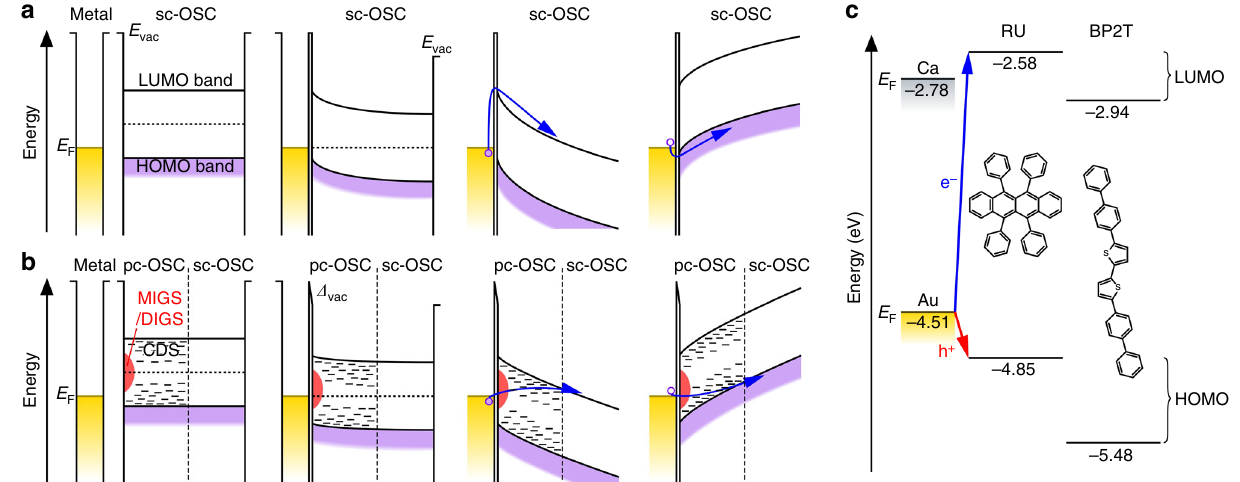
Fig. 2 Energy diagrams. Carrier injection mechanism of a metal electrode of Schottky limit and b new electrode consisting of a bilayer (polycrystalline organic semiconductor (pc-OSC)/tetratetracontane (TTC) covered by a metal thin fi lm (Au, Ca etc.) for FETs of single-crystalline OSC (sc-OSC). From left to right: separated metal and semiconductor, contacted metal and semiconductor, electron injection, and hole injection. c Fermi level ( E F ) of Ca and Au, HOMO and LUMO of rubrene (RU) and 5,5 ′ -di(4-biphenylyl)-2,2 ′ -bithiophene